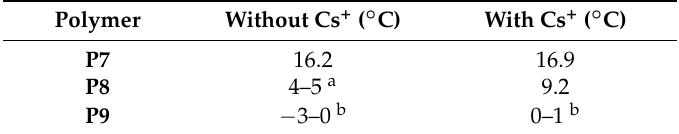
Table 2. Cloud point values of P7 , P8 , and P9 with/without Cs+ in water.